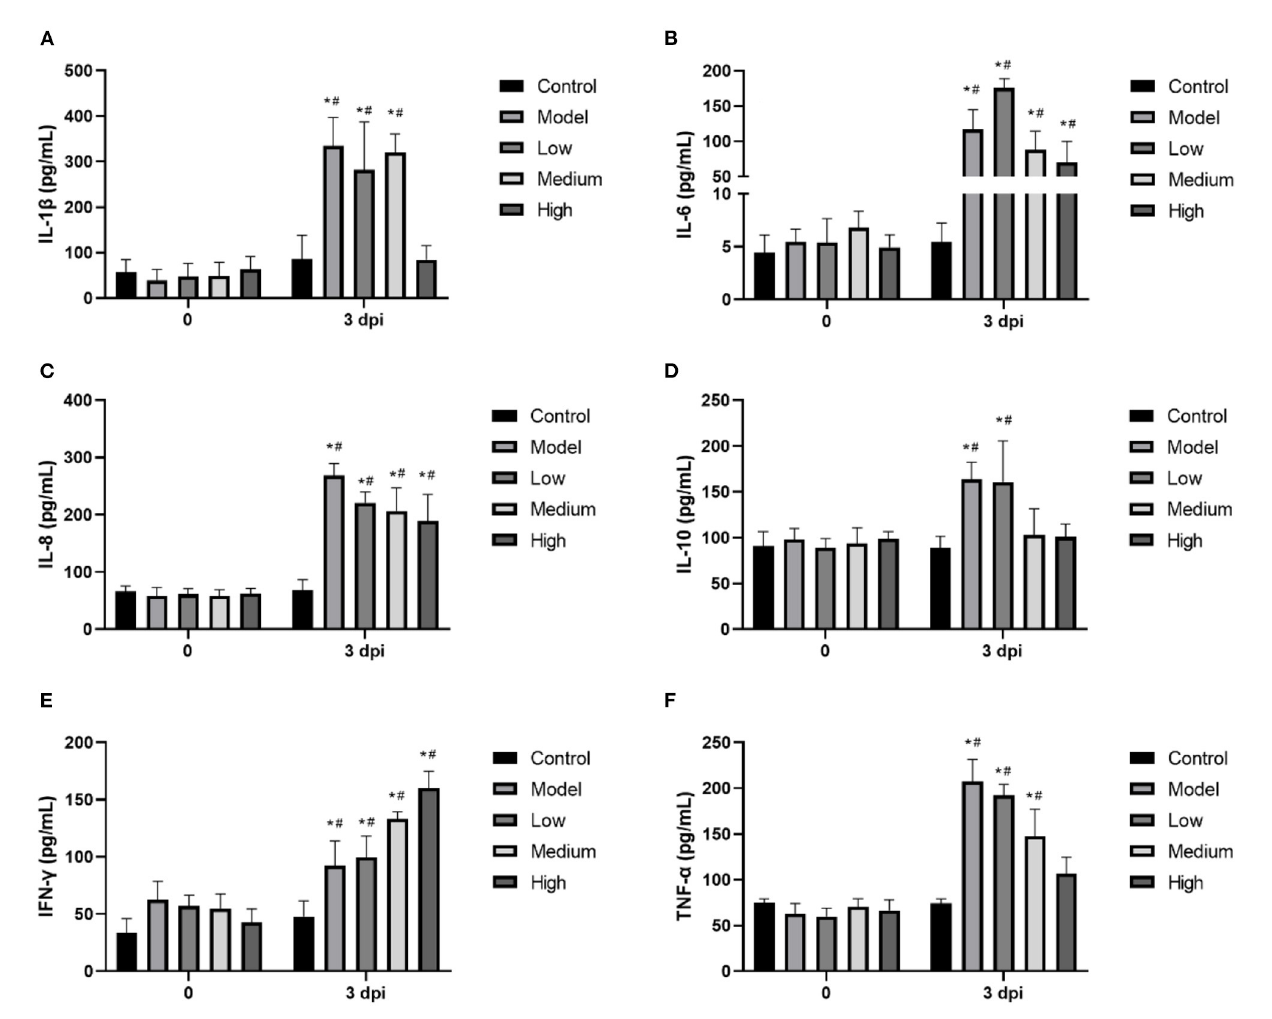
FIGURE6 (A–F) The relative mRNA expressions of cellular inflammatory factors IL-1 β , IL-6, IL-8, IL-10, IFN- γ . and TNF- α in piglet blood. Effects of monolaurin on cytokine release in piglet blood infected with SVV: * p < 0.05 vs. 0 dpi, # p < 0.05 vs.